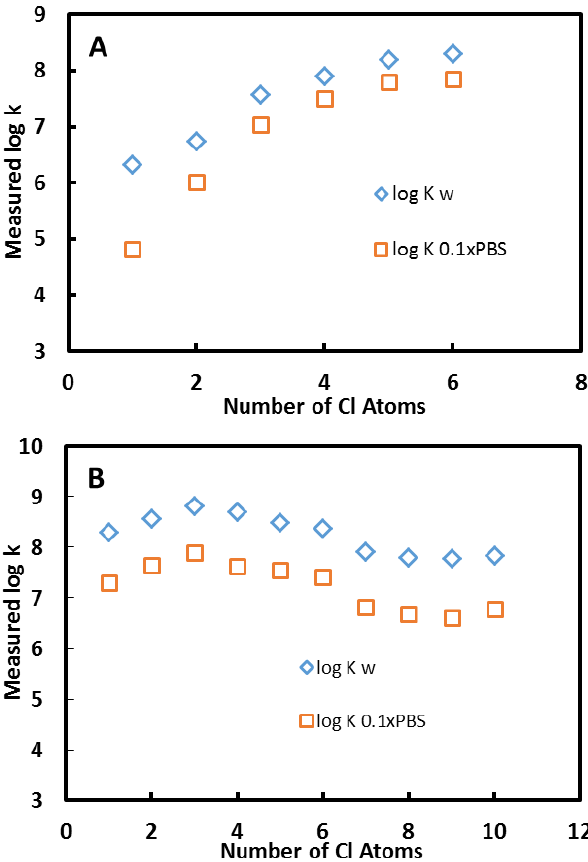
Figure 10. Effect of pH and ionic strength on the interaction of ZnO NPs and aromatic organochlo- rines. ( A ) Adsorption coefficients for chlorobenzene adsorption to ZnO NPs in HPLC water or 0.1 × PBS. ( B ) Adsorption coefficients for PCB adsorption to ZnO NPs in HPLC water or 0.1 × PBS. Solute concentrations were 0.01 mg/L and ZnO NP concentrations were 0.5